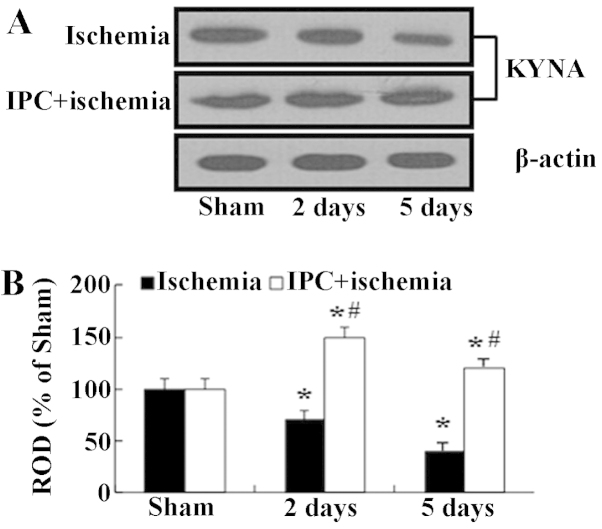
(A) Western blot analysis for kynurenic acid (KYNA) in the hippocampal CA1 region derived from the ischemia-operated and IPC + ischemia-operated groups. (B) Relative optical density (ROD) as percentage values of the western blot band is also represented (*P<0.05 vs. sham-operated group; #P<0.05 vs. ischemia-operated group). The bars indicate the means ± SEM.